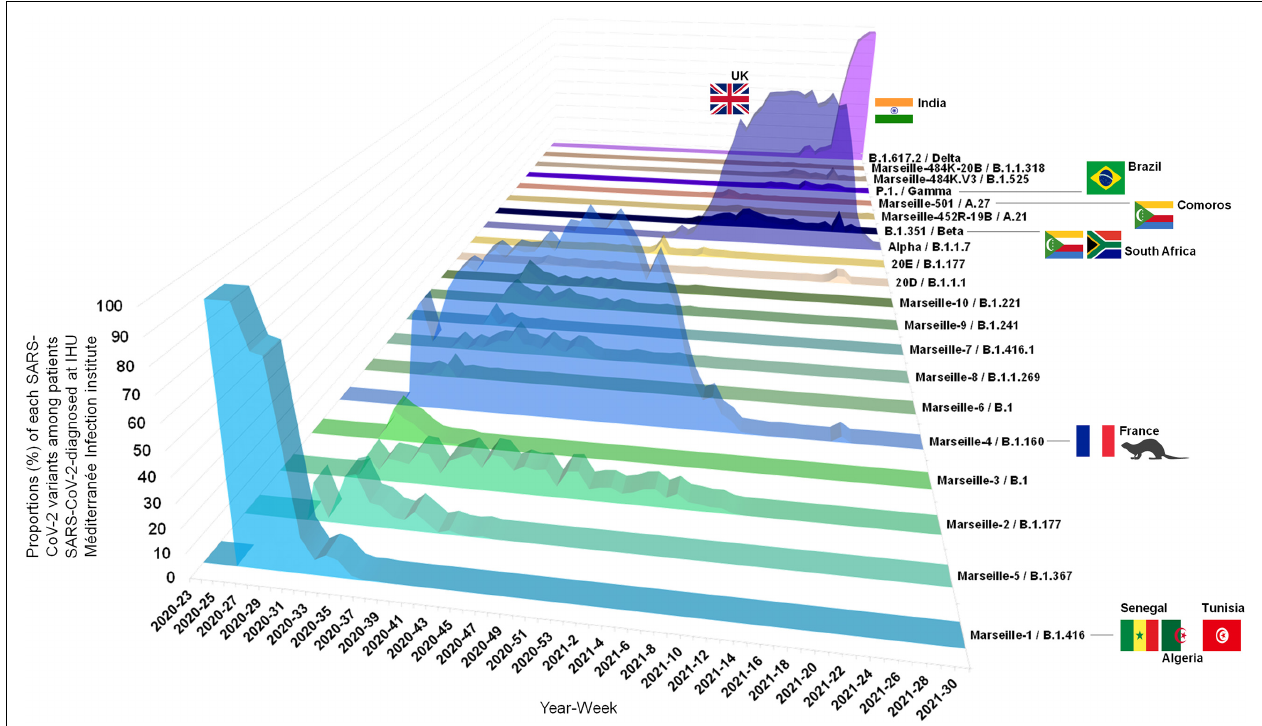
FIGURE 5 | Three-dimensional plot of weekly proportions accounted by each SARS-CoV-2 variants among patients SARS-CoV-2-diagnosed at IHU Méditerranée Infection institute. See also IHU Méditerranée Infection (2021a;